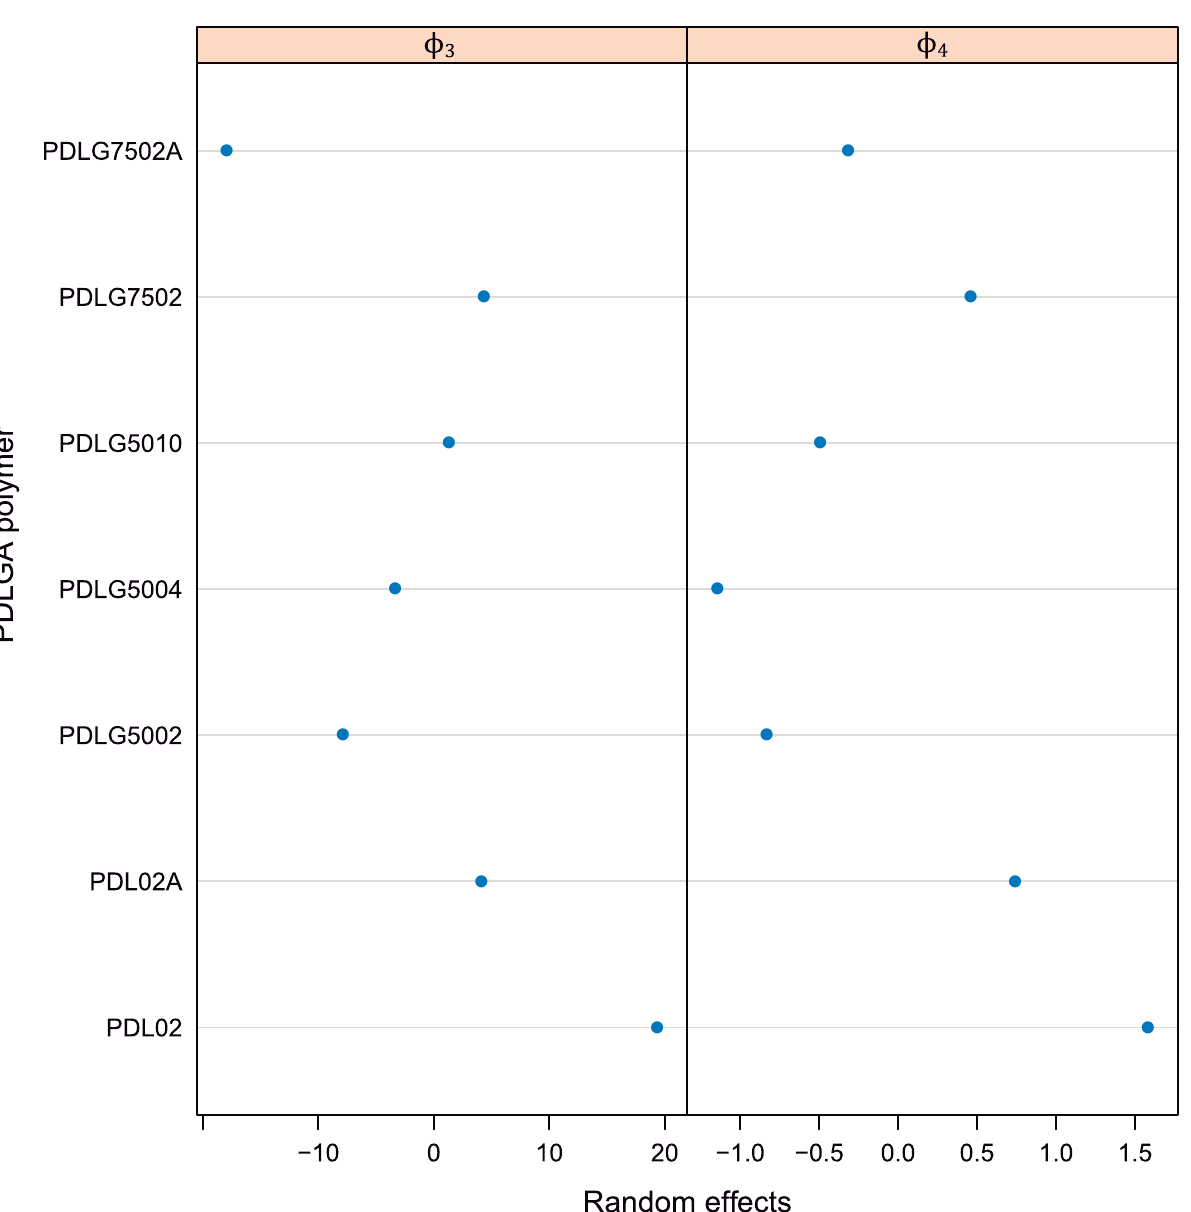
Fig 9. Random effects, b 3 i and b 4 i of ϕ 3 and ϕ 4 parameters corresponding to the nonlinear mixed-effect model of mass loss vs. time and PDLGA formulation.